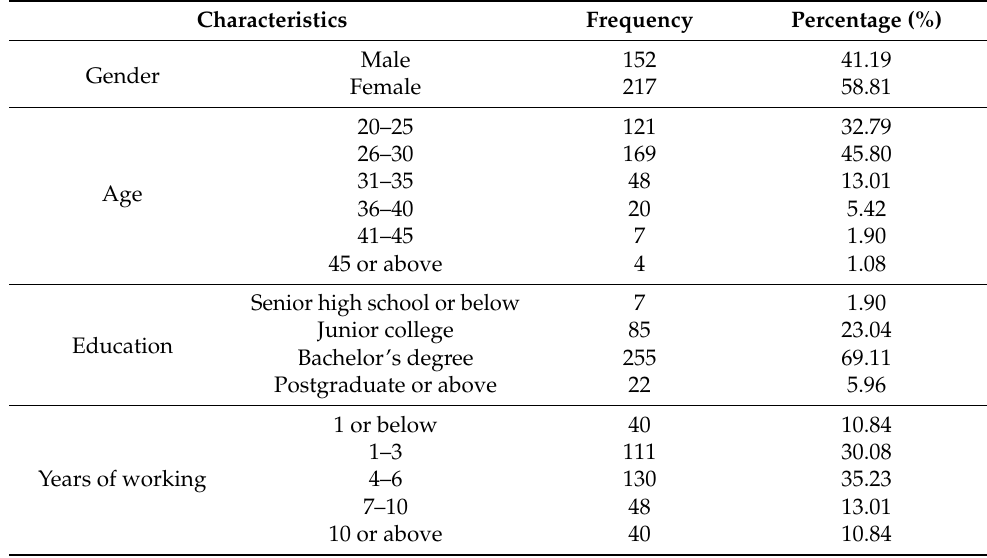
Table 1. Demographic